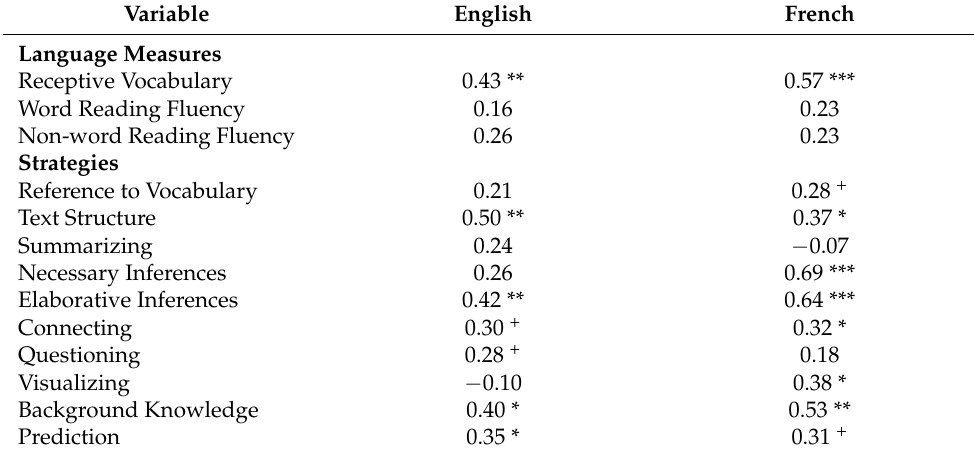
Table 3. Correlations of Language Measures and Strategy Use with Reading Comprehension Scores in Both English and